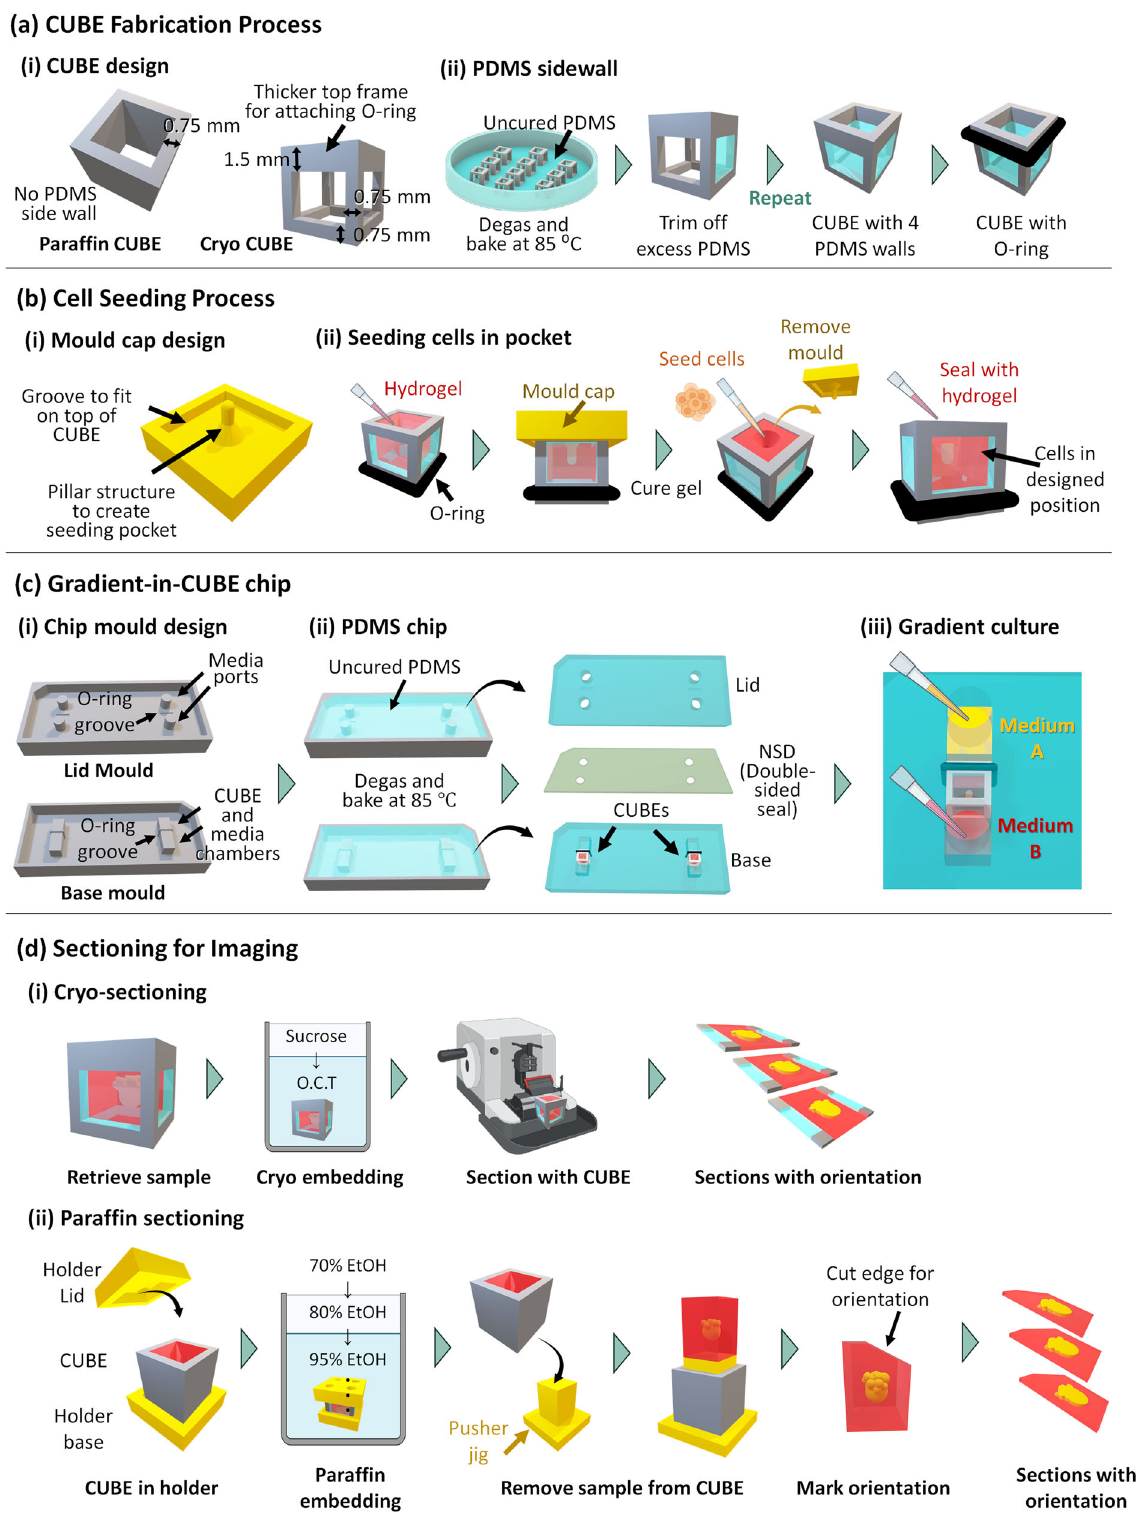
Fig. 2 Schematic diagram of fabrication and methods processes. a CUBE fabrication process (i) CUBE designs for paraf fi n and cryo sectioning. (ii) Process to adhere PDMS sidewalls to CUBE device. b Cell seeding process (i) Mould cap design. (ii) Process to seed cells in the seeding pocket created by the mould cap in the hydrogel in the CUBE. c Gradient-in-CUBE fabrication process (i) Designs for moulds to fabricate the lid and base of the chip. (ii) Process to fabricate PDMS chips from moulds, and adhering the lid to the base by NSD, a double-sided PDMS adhesive seal. d Sectioning for imaging. (i) Process to embed samples in cryo medium and sectioning with CUBE. (ii) Process to embed samples in paraf fi n with CUBE holder, then sectioning with a marked edge to maintain orientation of